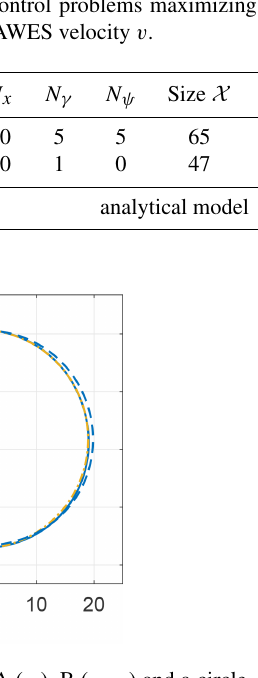
Figure 8. Optimal trajectory for OCP A ( − ), B ( − − ) and a circle with radius ˜ (cid:56) ( − . ).